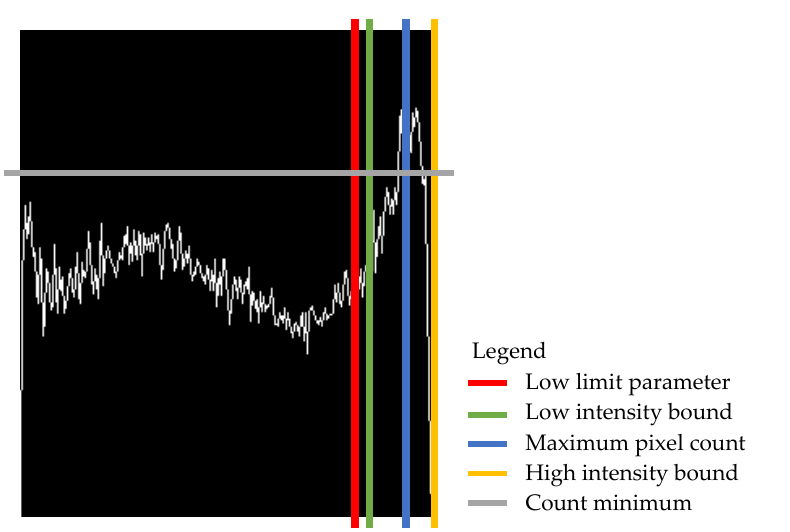
Figure 4. Histogram curve with thresholding parameters and boundaries displayed.